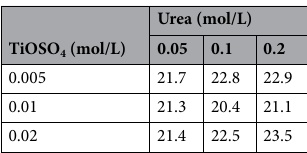
Table 2. Particle size of nano-TiO 2